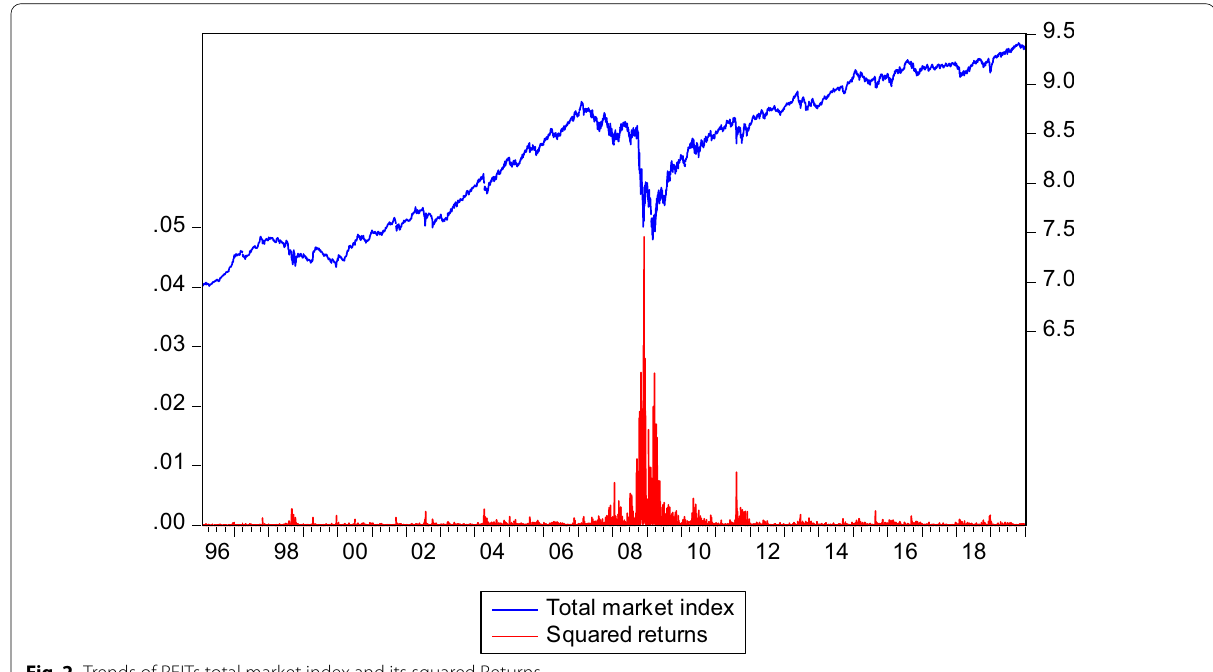
Fig. 2 Trends of REITs total market index and its squared Returns